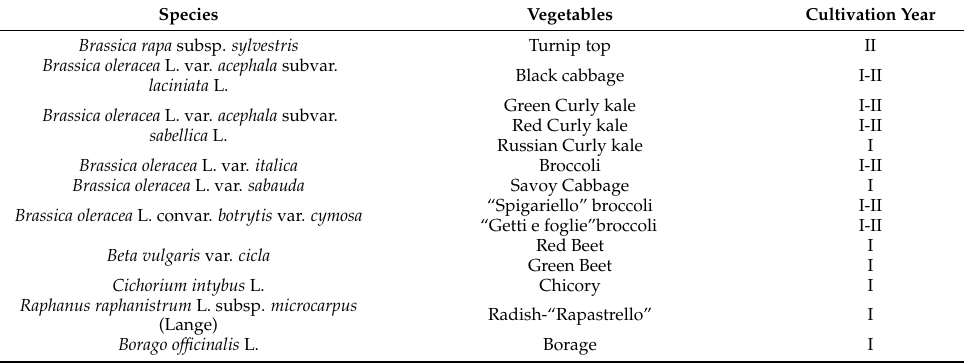
Table 1. Plant material analyzed during two years of